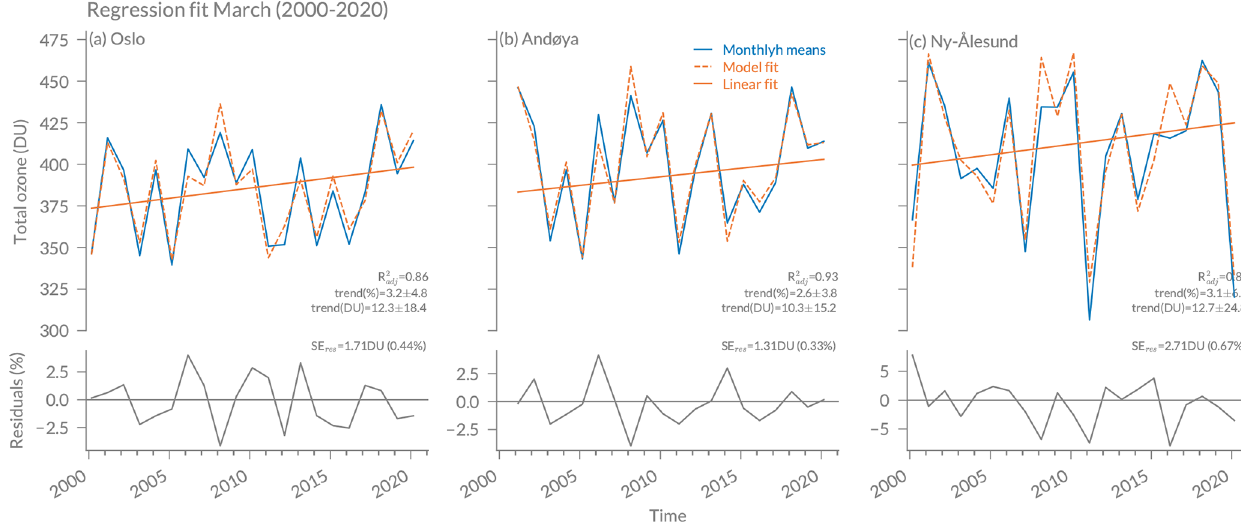
Figure 9. Same as Fig. 7 but for the month of